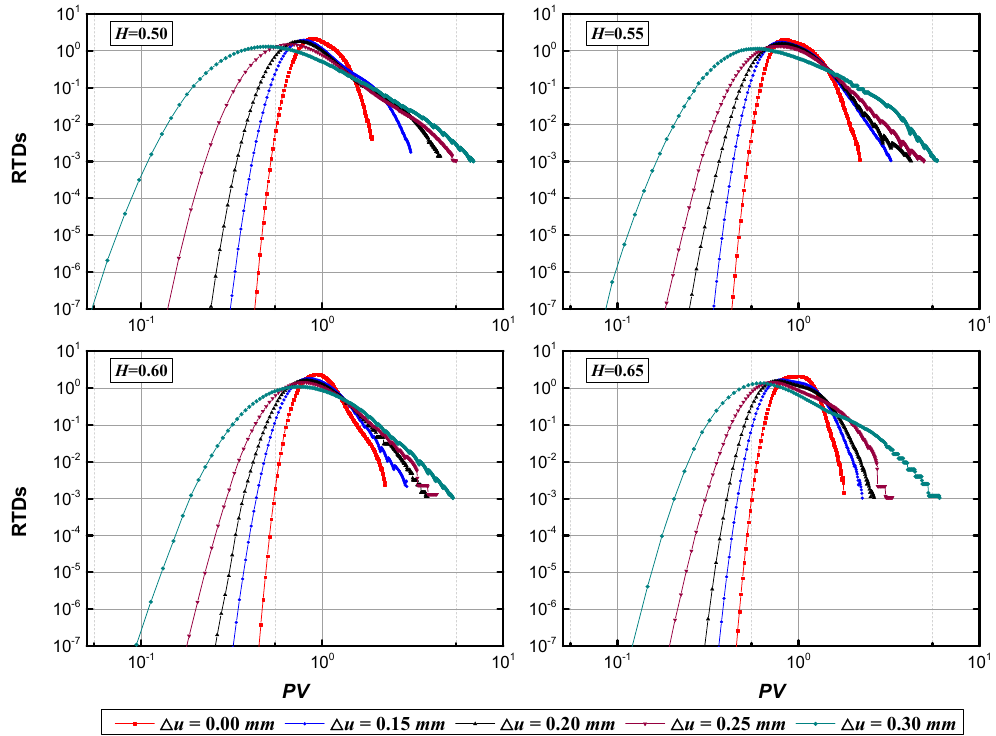
Figure 16. Variations of residence time distributions (RTDs) for fractures with different Δ u and H .